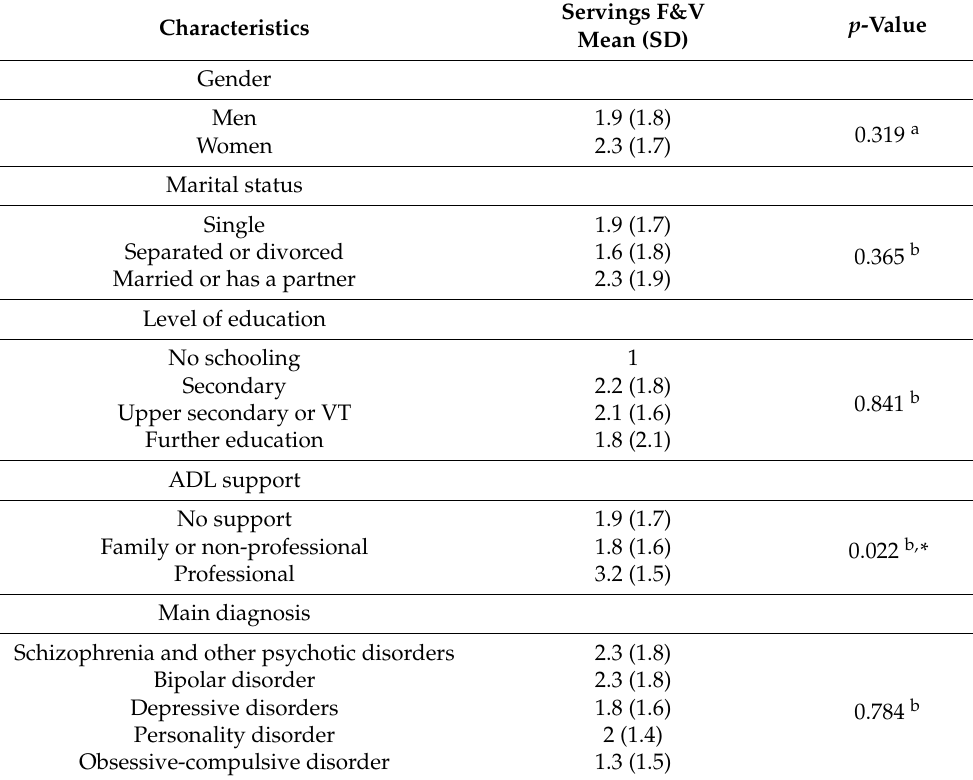
Table A1. Association between sociodemographic and clinical variables and F&V intake.